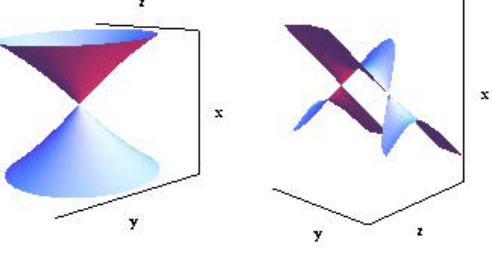
Fig. 12. Catenoid of the first kind (left) and the second kind (right) in L 3